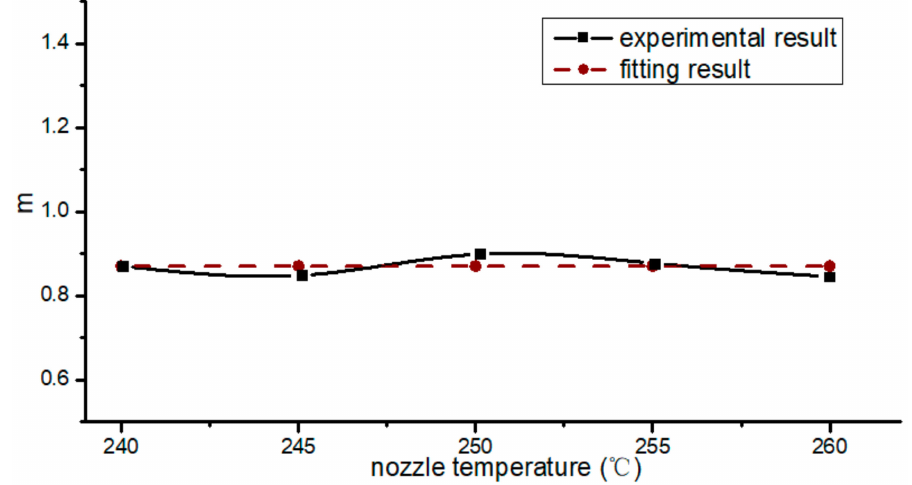
Figure 8. Optimal ratio of extrusion velocity to filling velocity at di ff erent